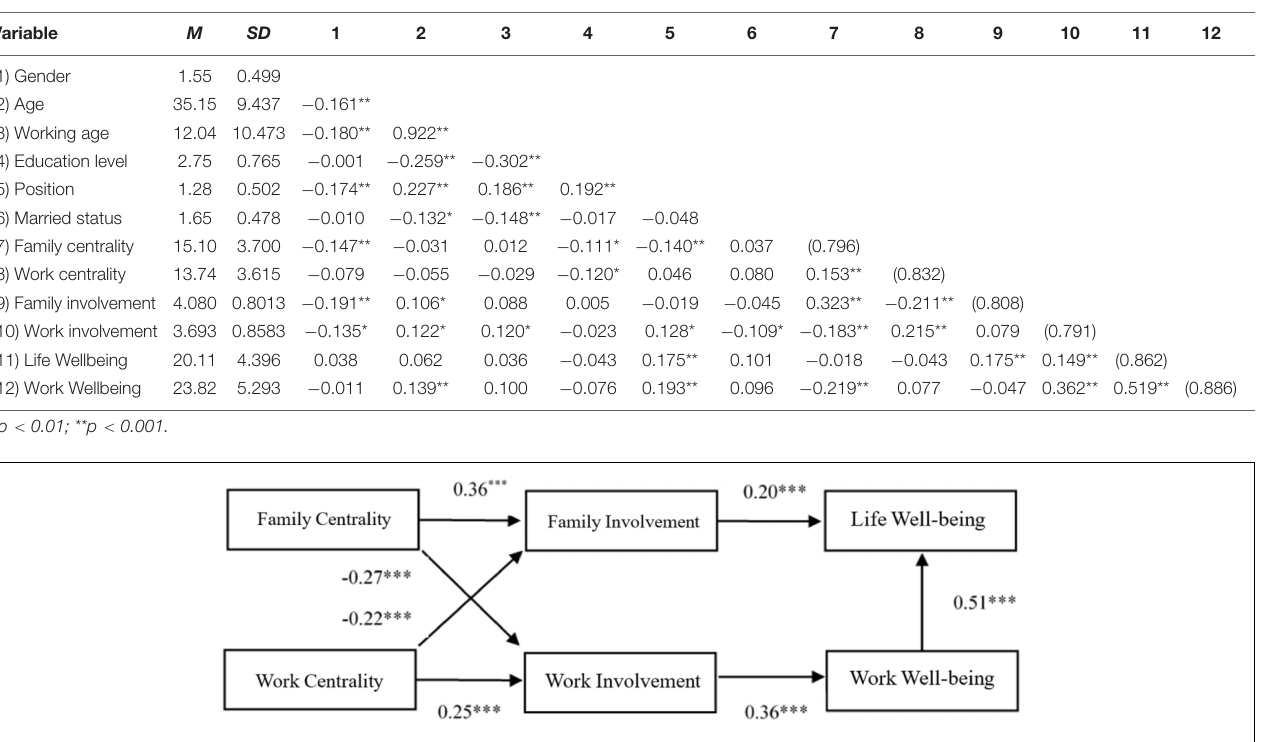
FIGURE 2 | Path coefficient diagram. For clarity, the control variables and their paths were not marked. ∗∗∗ p <